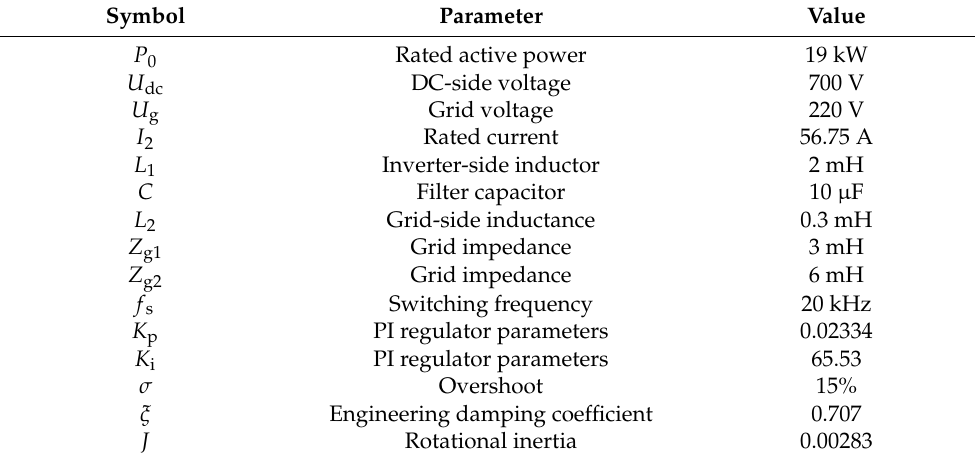
Table 1. Simulation platform parameters.